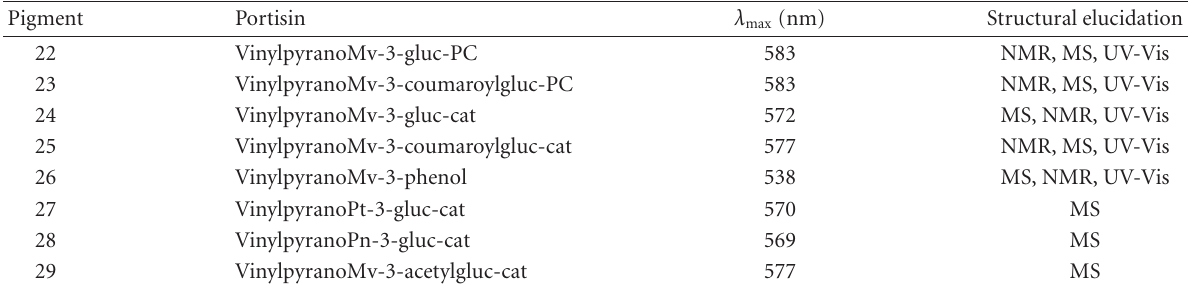
Table 2. Portisins detected in Port wine fractions. (Mv = malvidin; Pn = peonidin; Pt = petunidin; gluc = glucoside; cat = catechin; PC = procyanidin dimer.)